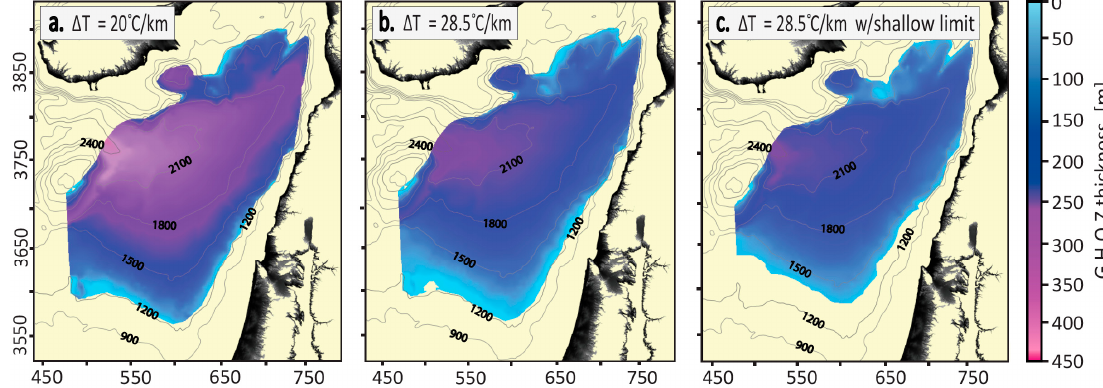
Figure 4. The model predicted the extent and thickness (color coded on the right) of the potential gas hydrates occurrence zone (GHOZ) below the Levant Basin seafloor (plotted with UTM coordinates in km). ( a ) The GHOZ estimated by the sub-seafloor part of the GHSZ under a geothermal gradient of 20 ◦ C / km. ( b ) The GHOZ estimated by the sub-seafloor part of the GHSZ under a geothermal gradient of 28.5 ◦ C / km. ( c ) The GHOZ, estimated from the GHSZ under a geothermal gradient of 28.5 ◦ C / km and top bound 25 m below the seafloor, as inferred from the presence of the shallow high amplitude seismic reflectivity (HASR) (see Section 4.5 text). This map constitutes our conservative estimate for the potential GHOZ in the Levant Basin.